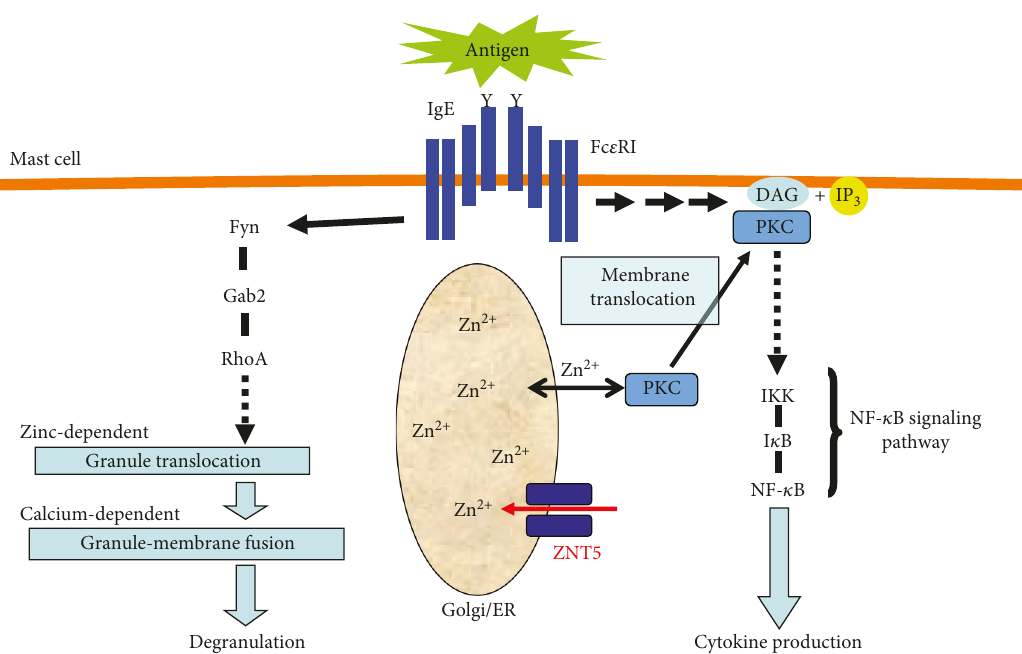
Figure 1: Zinc and zinc transporters are involved in Fc ε R Ι -mediated mast cell activation. Zinc is required in multiple steps of Fc ε R Ι -induced mast cell activation, including degranulation and cytokine production. Zinc levels depend on Fc ε R Ι -induced granule translocation, regulated by a Fyn/Gab2/RhoA-mediated signaling pathway. Zinc and ZNT5 are also required for PKC ’ s translocation to the plasma membrane and NF- κ B ’ s subsequent nuclear translocation, leading to the production of cytokines such as IL-6 and TNF α . IgE: immunoglobulin E; Fc ε R Ι : high-a ffi nity receptor for IgE; Gab2: Grb2-associated binding 2; Zn: zinc; ZNT5: Zn transporter 5; ER: endoplasmic reticulum; PKC: protein kinase C; DAG: diacylglycerol; IP : inositol-1,4,5-triphosphate; IKK: inhibitor of kappa B kinase; I κ B: inhibitor of kappa B; NF- κ B: 3 nuclear factor-kappa